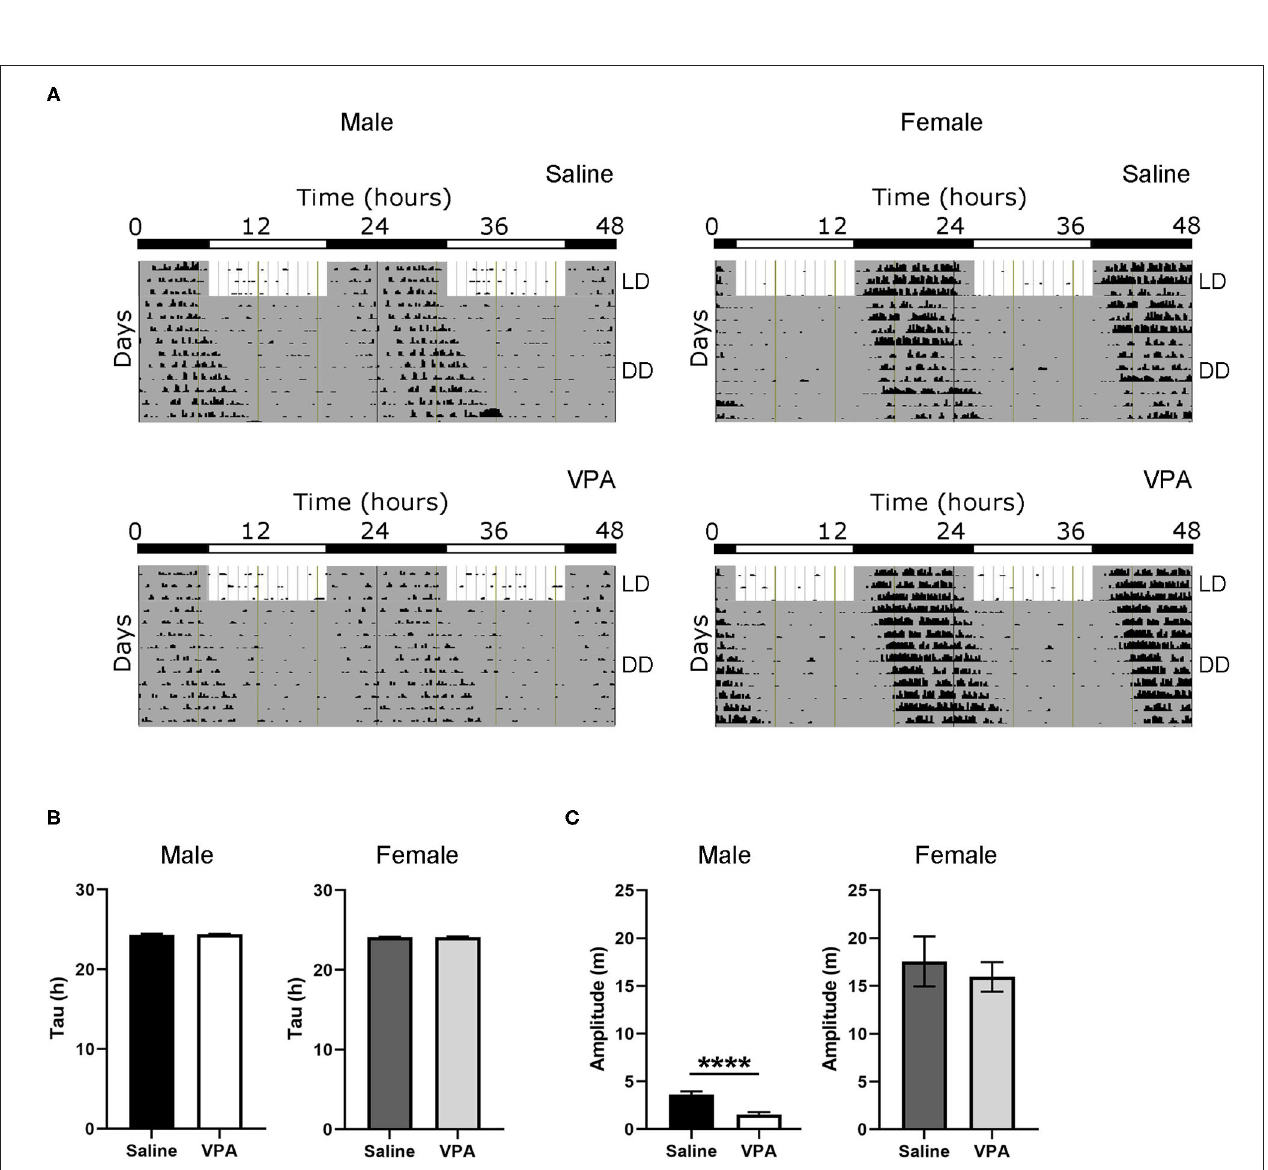
FIGURE 2 | Behavioural rhythms are diminished in VPA-exposed males under constant dark (DD) conditions. (A) Representative double-plotted actograms from (left panel) saline-exposed males and VPA-exposed males. Right panels represent double-plotted actograms from saline-exposed females and VPA-exposed females, maintained under constant dark conditions. (B) Tau (hours), or the period of the endogenous free-running rhythm, is unchanged between VPA-exposed males/females and saline-exposed males/females. (C) Amplitude (m) is lessened under DD conditions in VPA-exposed males (saline: M = 3.618 ± 0.3464, VPA: M = 1.545 ± 0.8215, p < 0.0001). Data was analysed using a two-tailed unpaired t -test (or Welch’s correction when appropriate) and are plotted as mean ± SEM. **** p ≤ 0.0001.